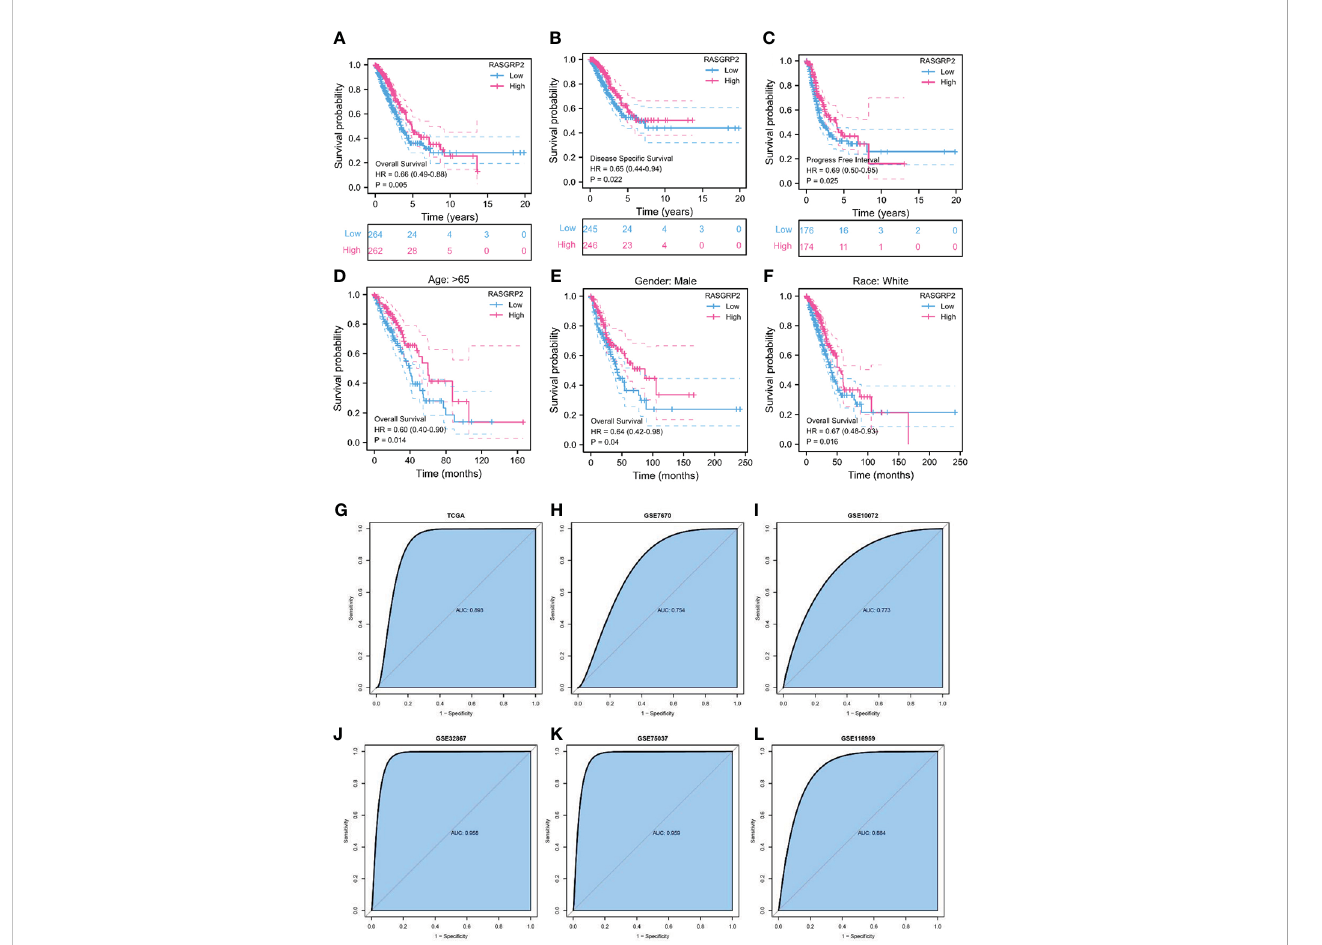
FIGURE 3 The prognosis and diagnostic value of RASGRP2 in LUAD. The OS (A) , DSS (B) , and PFI (C) survival curves analysis indicated that patients with lower RASGRP2 had poor prognosis (P < 0.05). (D-F) Subgroup analysis for age greater than 65 years, male and white patients. (G – L) The diagnostic ROC curves of RASGRP2 in TCGA, GSE7670, GSE10072, GSE32867, GSE75037 and GSE116959 datasets.